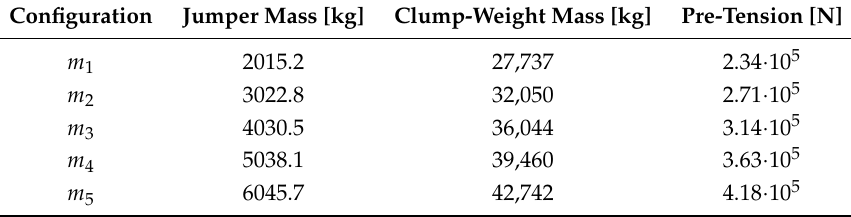
Figure 4. Map of jumper mass ( M J ) and clump-weight mass ( M C ) to the resulting draft of the top cylindrical section of the floater. Five different configurations are studied ( m 1 to m 5 ), as tabulated in Table 4, all resulting in a draft of 7.91 m. Table 4. Jumper and clump weight masses for five different mooring configurations that ensure the same draft of the top cylinder of the floater L c of 7.91 m, as shown in Figure 4. The consequent pre-tension is also reported.